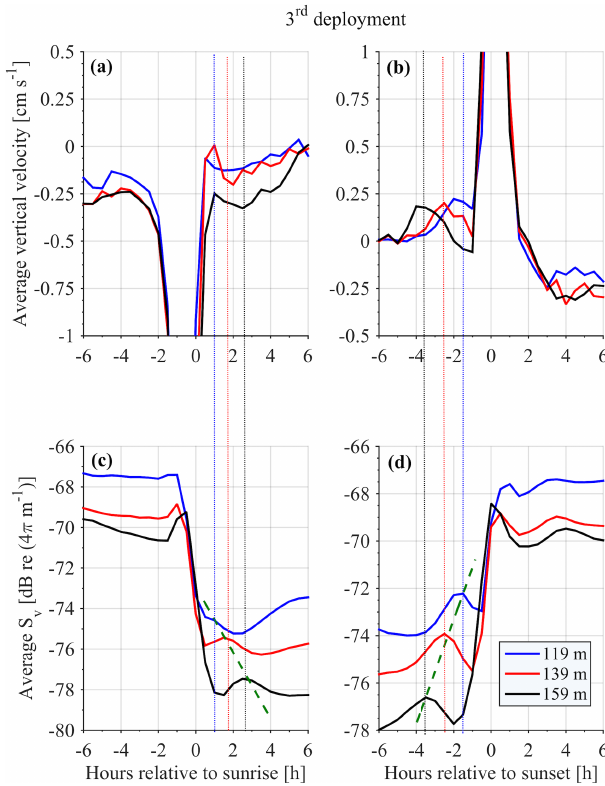
Figure 11. Time average vertical velocity (a, b) and S v (c, d) at selected depths during the third deployment. The green dashed line connects the S v peaks attributed to group D. The vertical dotted lines are used to emphasize the common peaks of vertical velocity and S v attributed to group